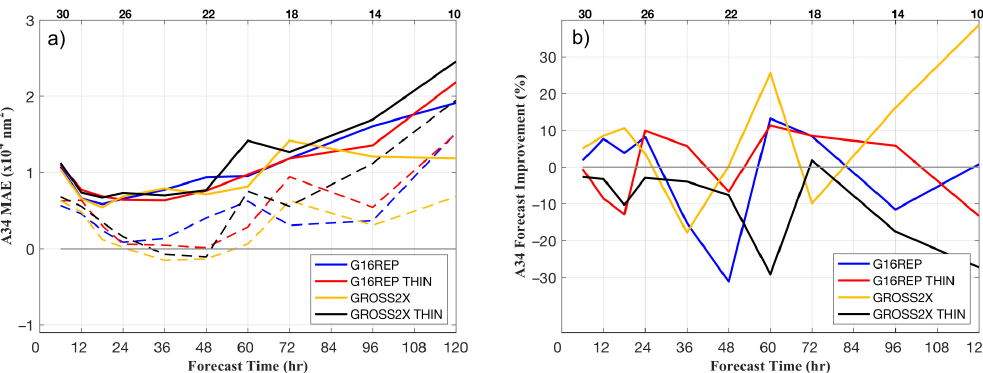
Figure 9. Hurricane Irma (2017) HWRF areal extent of 34-kt winds (A34) (10 4 nm 2 ) forecast MAE (solid) and bias (dashed) verified against NHC Best Track for G16REP (blue), G16REP THIN (red), GROSS2X (gold), and GROSS2X THIN (black) in ( a ). Percentage improvement in MAE relative to BASE is shown in ( b ). The number of verifying forecasts for each lead time is shown in black across the top of each plot.